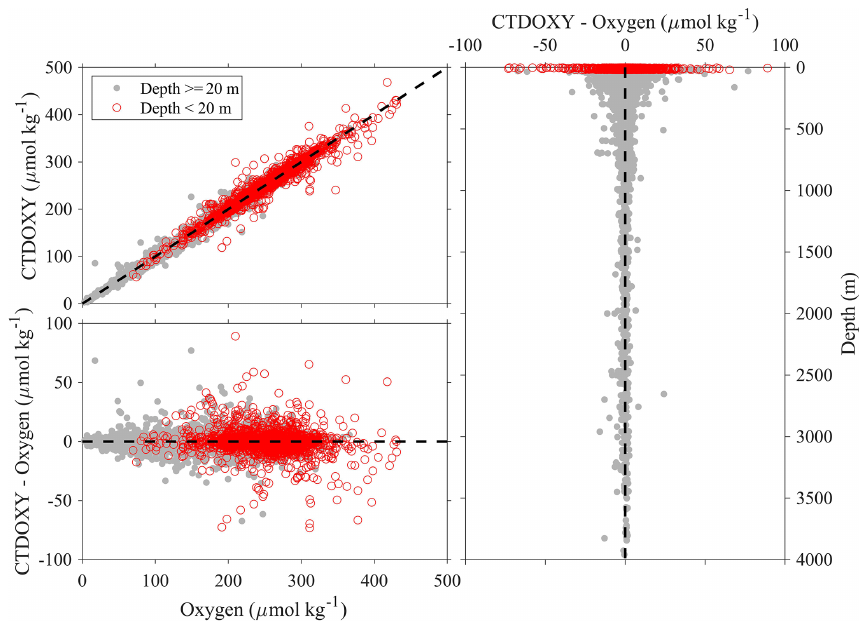
Figure 8. Comparison plots of dissolved oxygen measured from sensors mounted on CTD (CTDOXY) and dissolved oxygen that is measured from Winkler titration (Oxygen).